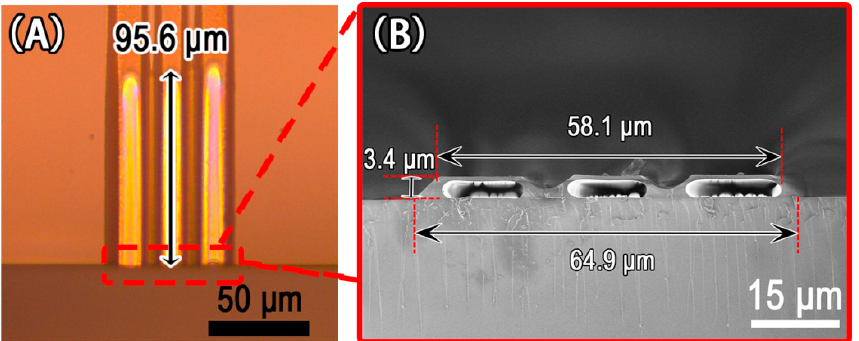
Figure 7. Images of three parallel microchannels fabricated with a PDMS guiding mold: ( A ) surface microscope photograph; ( B ) SEM image of the cross-section.